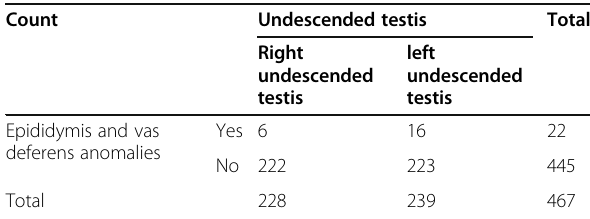
Table 2 Epididymis and vas deferens anomalies in cross tabulation with the laterality of the undescended testicle